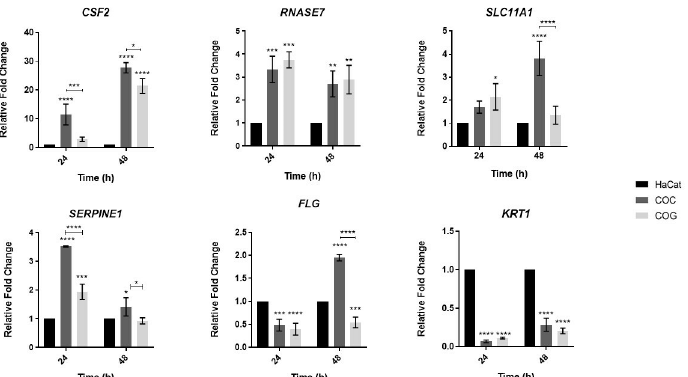
Figure 2. Expression levels of genes involved in the innate immunity ( CSF2 , RNASE7 , SLC11A1 , and SERPINE1 ) and epithelial barrier integrity ( KRT1 and FLG ) of human keratinocytes in response to fungal elements of T. rubrum . HaCat: cultured keratinocytes used as control; COC: co-culture with the conidial phase of T. rubrum ; COG: co-culture with the germinative phase of T. rubrum . Asterisks indicate significant differences (* p < 0.05; ** p < 0.01; *** p < 0.001; **** p < 0.0001) . 3.4. Analysis of Expression of Genes Involved in the Innate Immune Response of Keratinocytes Co-Cultured with Heat-Inactivated Fungal Elements of T. rubrum Expression analysis of human genes involved in the immune response, and epithelial barrier integrity of keratinocytes using heat-inactivated fungal elements in different de-